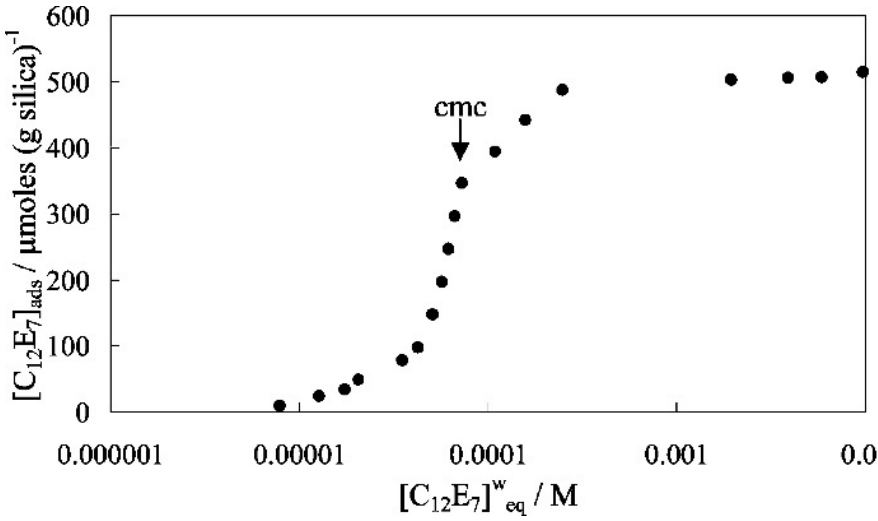
Figure 5. Adsorption isotherm of C 12 E 7 surfactant onto N20 silica particles (2 wt %) in water. Biomass-Derived